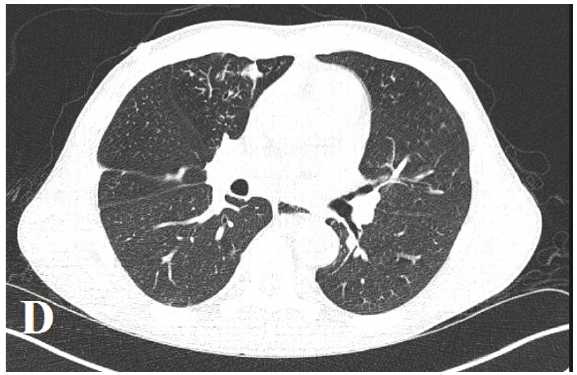
Figure 4: Resolution of hydropneumothorax.